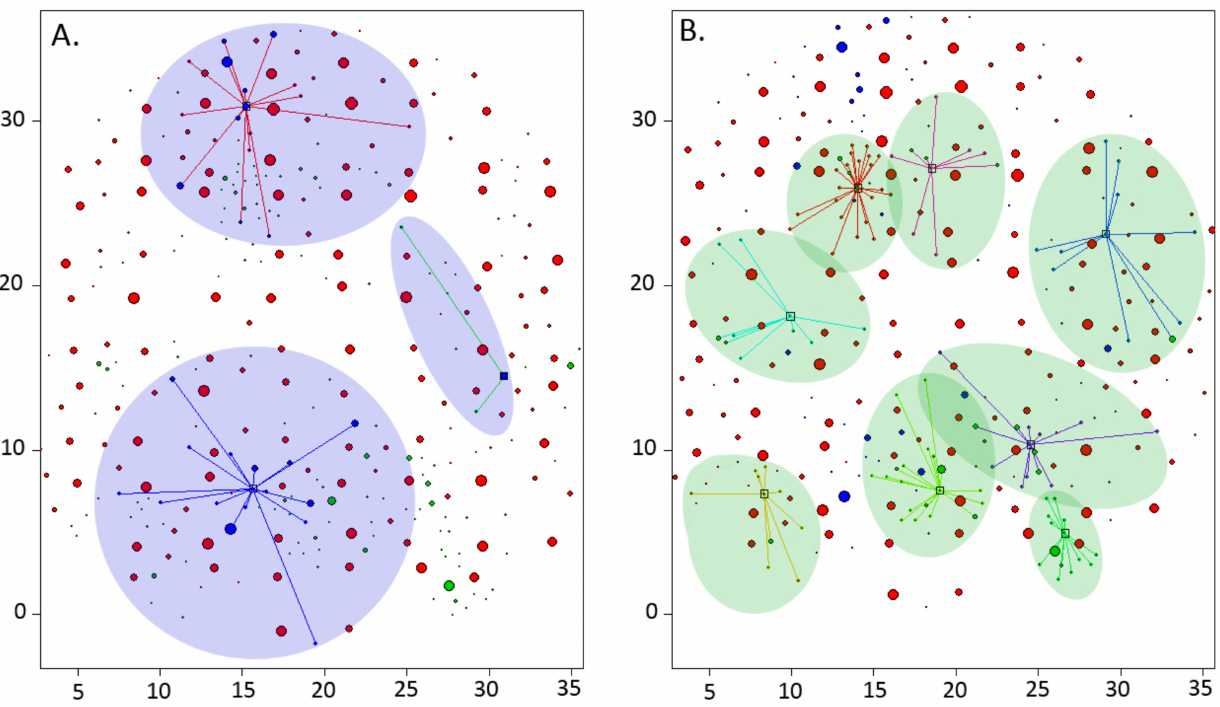
Figure 2. Example of intraspecific clustering throughout a stand for ( A ) balsam fir and ( B ) hardwoods. All the trees within a given cluster are connected by a set of lines of the same colour. The coloured surface was added afterward to facilitate the viewing of